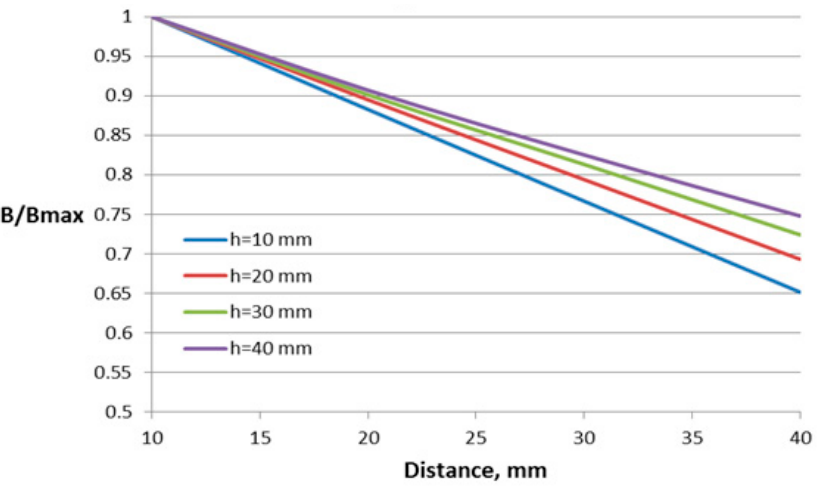
Figure 11. Dependence of the flux density on the distance to the conductor for the concentrator with two gaps and different window heights h .